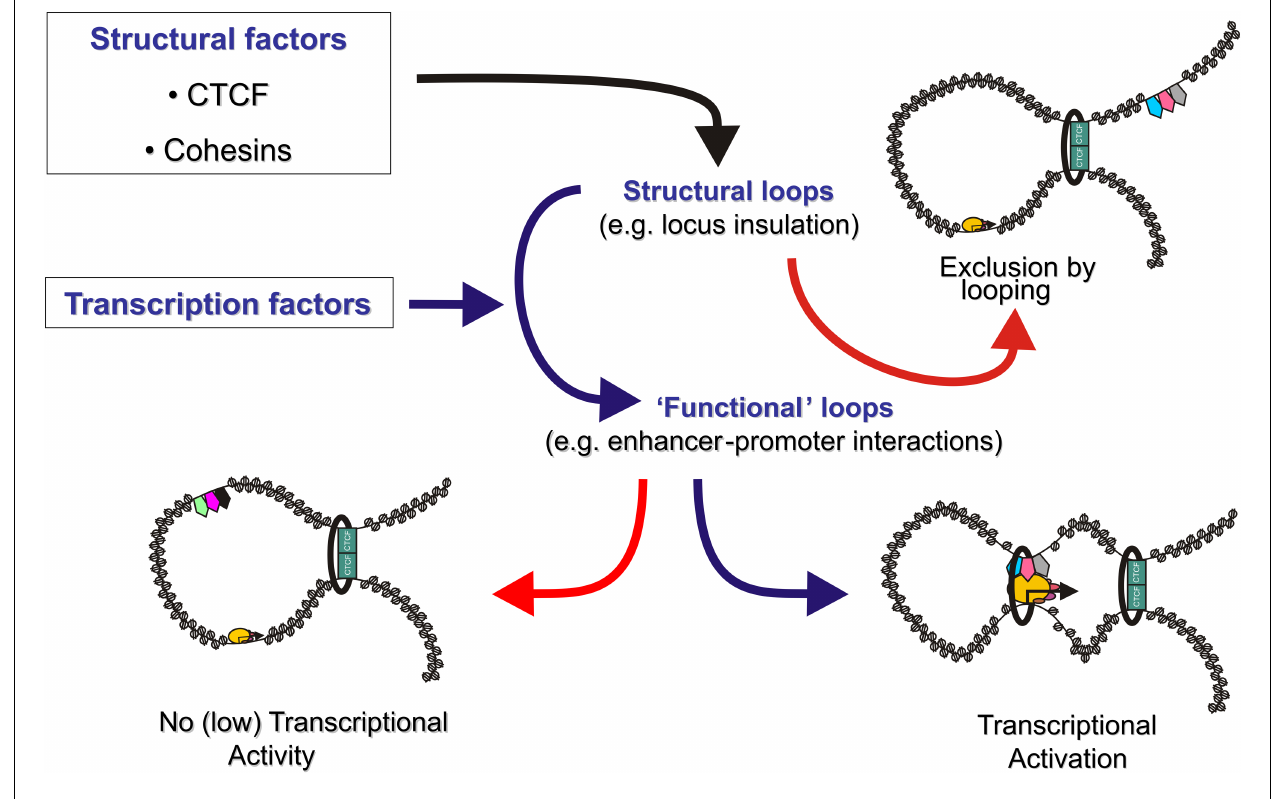
transcription factors (pentagons) either induce enhancer–promoter communication via a chromatin loop (bottom right) or keep enhancers in a silent/poised state (bottom left). Rectangles depict CTCF, the black ring represents the cohesin complex, pentagons depict enhancer bound transcription factors and ovals depict components of the pre-initiation complex. Size of the icons depicts strength of binding or